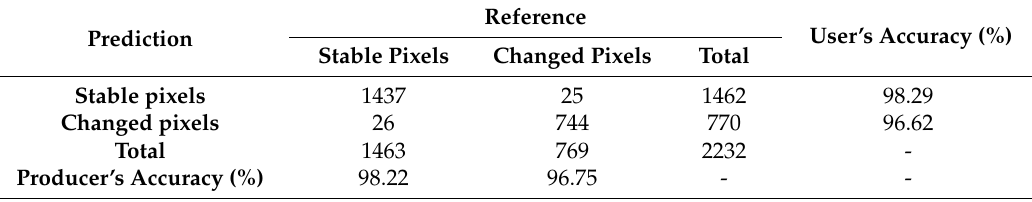
Table 2. Change detection assessment of HSMM-based post-classification algorithm.